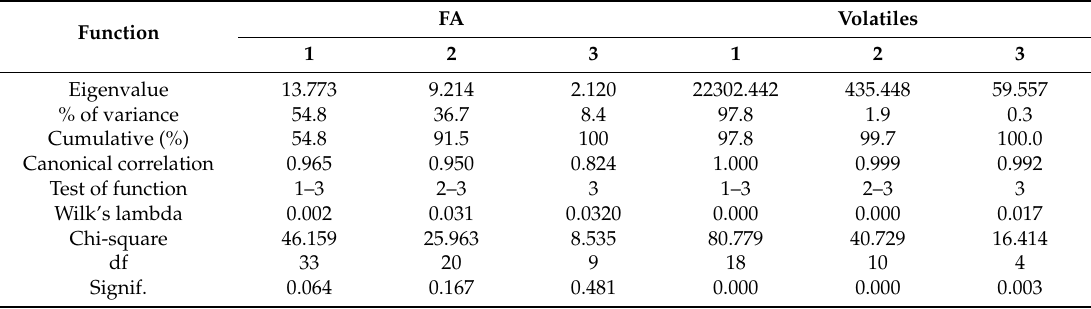
Table 4. Fisher’s linear discriminant functions and functions at group centroids obtained from LDA analysis using FA or volatiles percent compositions of monovarietal EVOO